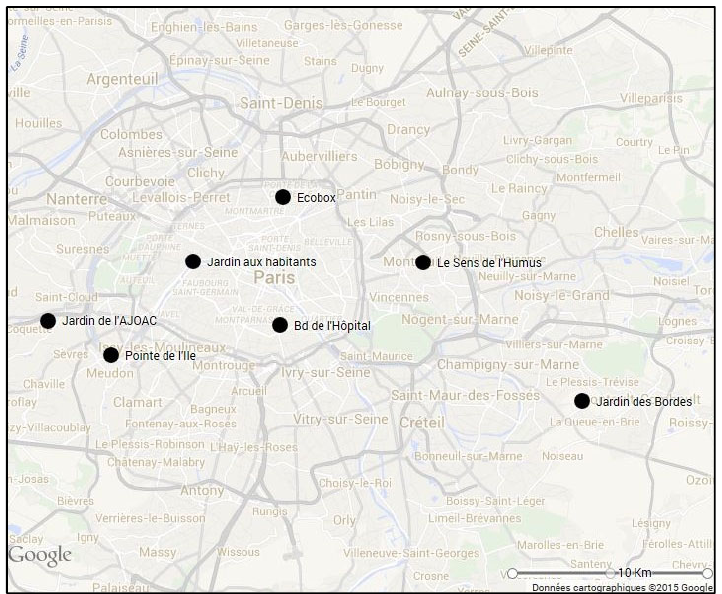
Figure 1. Map of Gardens Selected in Paris